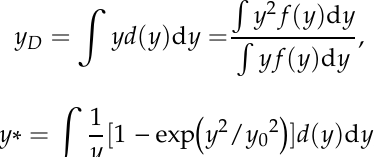
Figure 1. Note that the relation T = N ∆ T can be obtained, where N is the number of sub-sections in dose-delivery time T in h. By solving the rate equations for PLLs and LLs reported previously [33], the number of LLs per domain w d , which may lead to cell-killing, can be obtained as